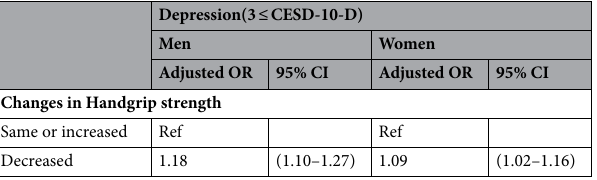
Table 4. Results of the GEE analysis of handgrip strength change and depression. All variables in Table 2 were included in the GEE